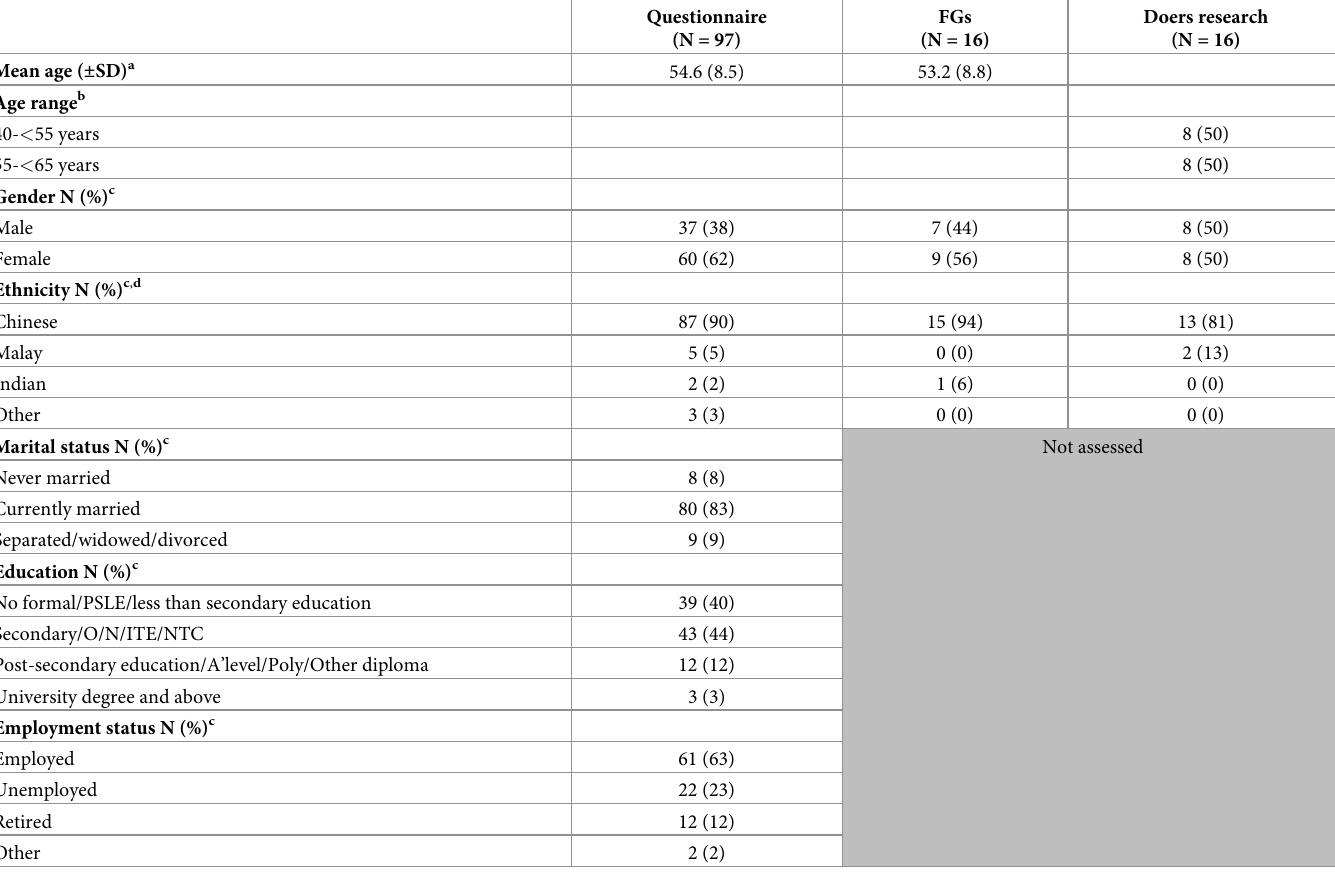
Table 1. Participant characteristics per study component, reflecting total numbers and respective proportions (%), except for age, for which mean ± SD or age range are